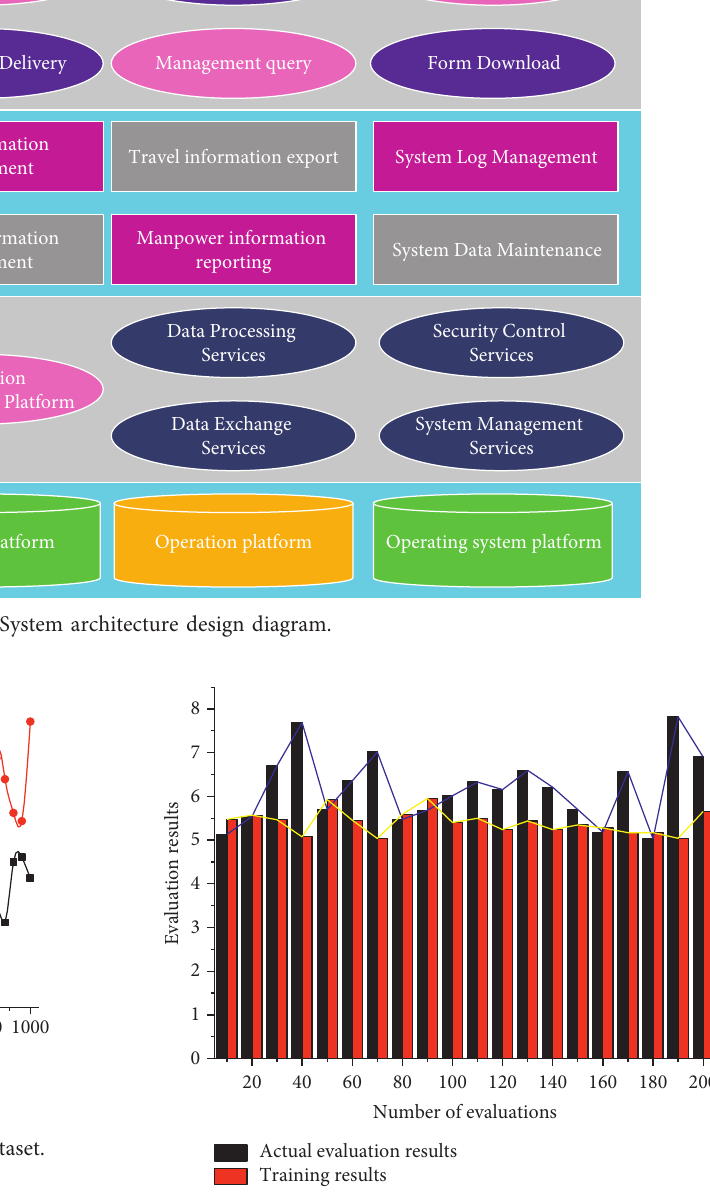
Figure 4: Model evaluation